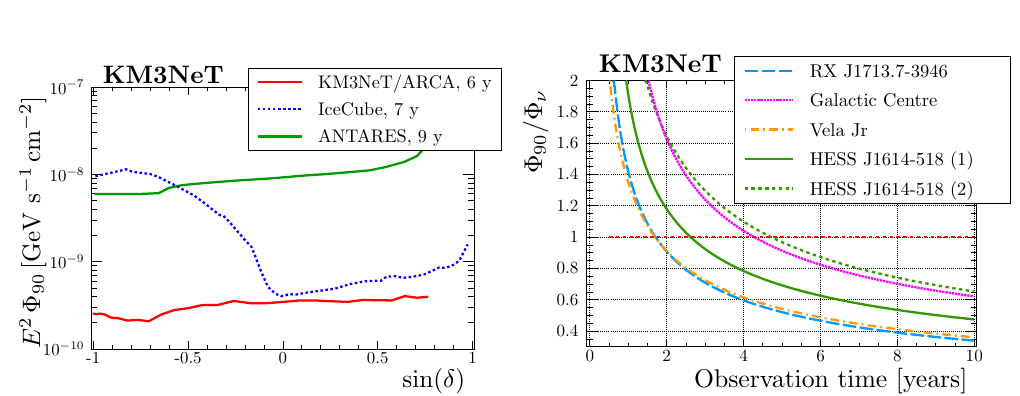
Figure 5. Left: ARCA sensitivity for a generic, unbroken E − 2 neutrino flux as a function of the source declina- tion. For comparison, the corresponding IceCube [4] and ANTARES [5] results are also shown. Right: ratio of ARCA sensitivity to the expectation flux as a function of the observation time for some galactic sources. See ref. [6] for details.